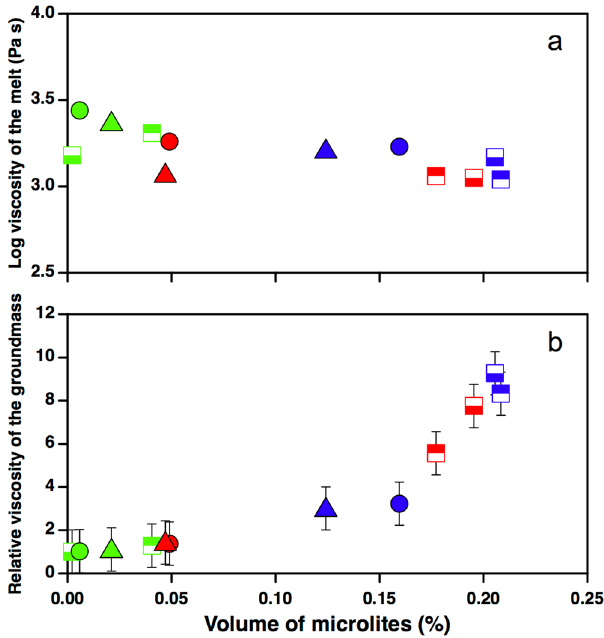
Figure 7. ( a ) Log 10 of the Newtonian viscosity determined only for the melt phase at 1100 °C using the GRD model 61 within clasts with a variable microlite content; ( b ) relative viscosity of the groundmass (melt + crystals) as a function of crystal fraction calculated on the basis of eq. 23 of the 29 model, using an average crystal aspect ratio of 2.5 to 9.5, shear rates (4.8 10 − 3 –7.4 10 − 4 s − 1 ) were calculated from MDR estimated by 8 , assuming 1000 m-long conduit with a radius of 20